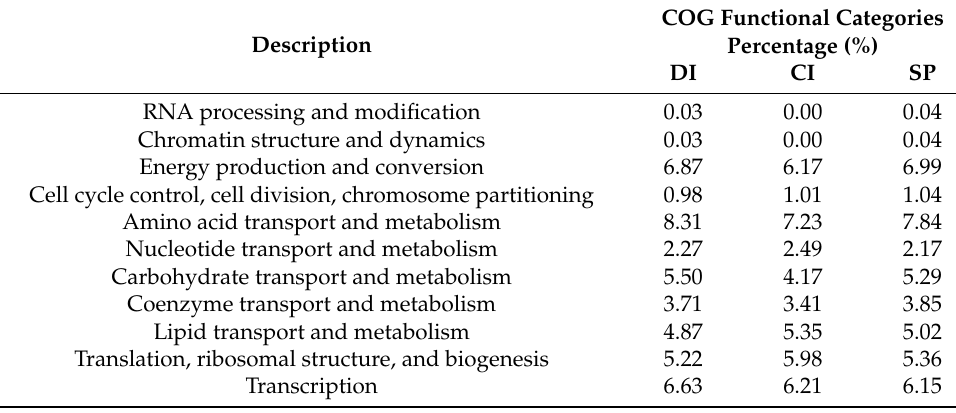
Table 6. Comparison of COG functional categories percentage for SP, CI, and